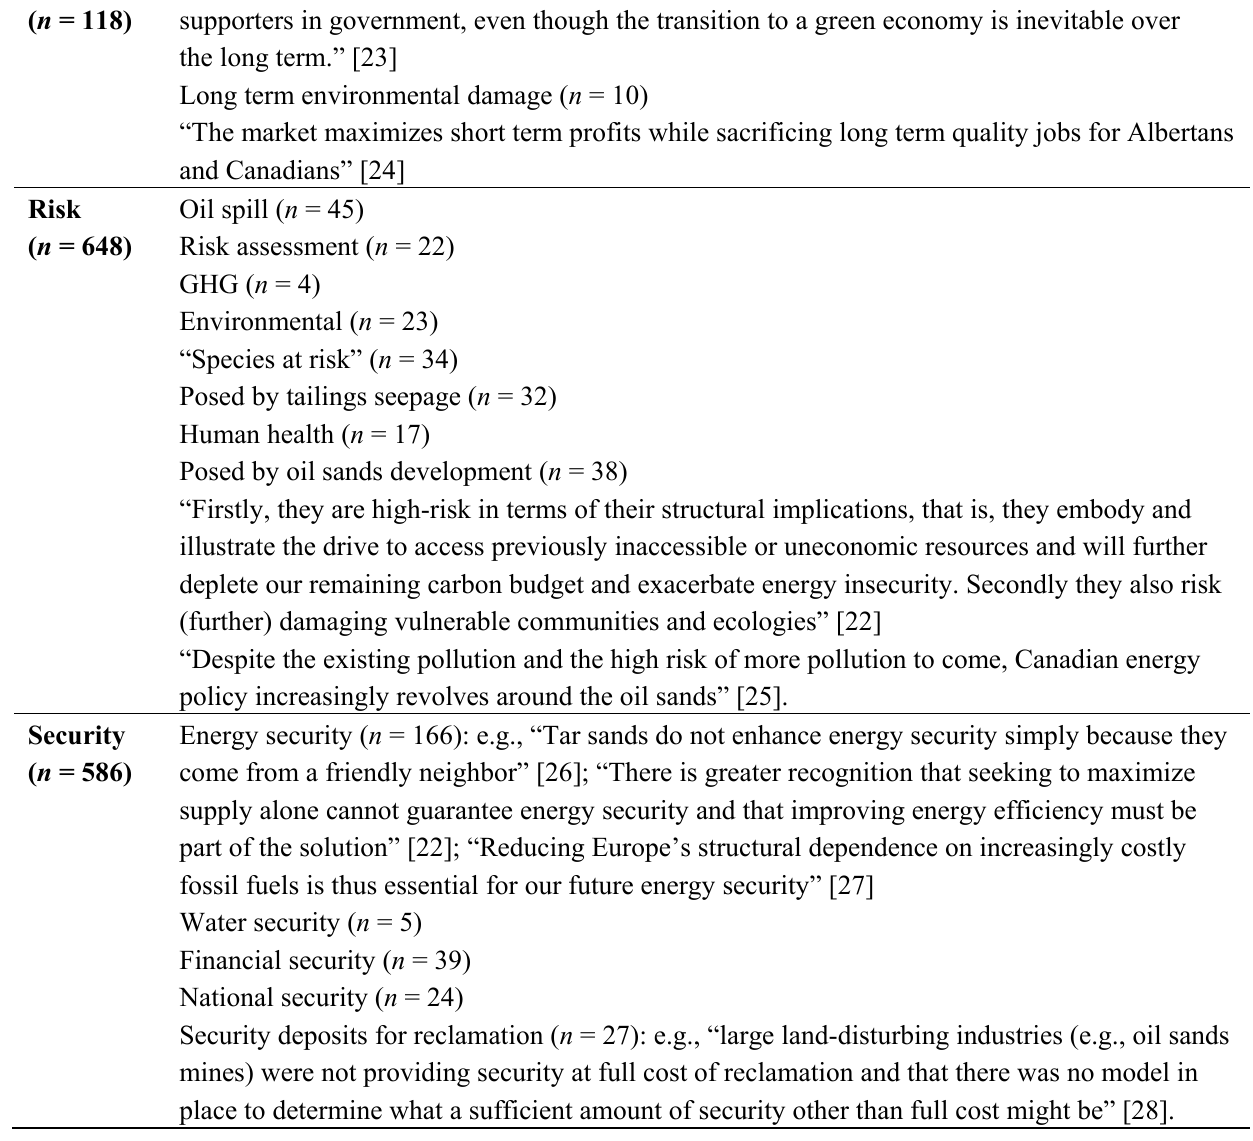
Table 1. Keywords discussing damage caused by industry in non-governmental organization (NGO) reports ( n = numbers of hits). GHG: green house